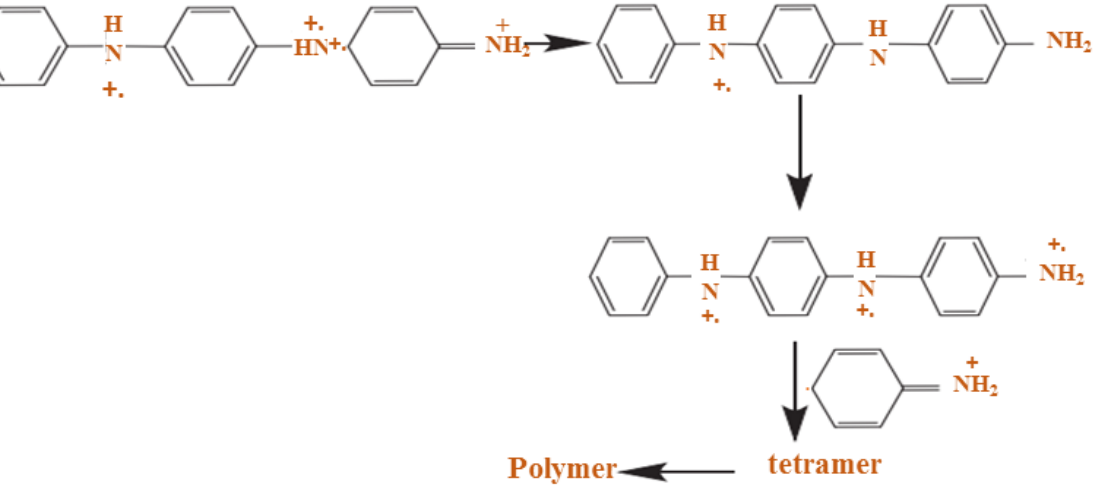
Figure 9. Structure for the radical cation of dimer. Reproduced with permission from Materials